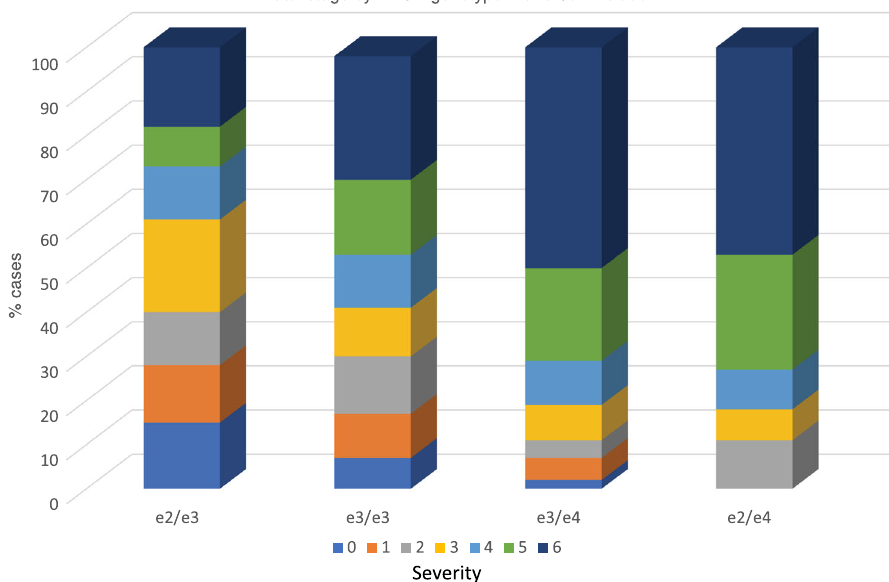
Fig. 3 Association of APOE e2/e4 genotype with Braak stage. Within each APOE genotype column, colored rows represent the relative proportion of cases in each severity stage. These proportions are expressed as percentages and add to 100. Note the similarity of e2/e4 cases to e3/e4 cases with respect to high levels of tau pathology. Braak stage 0 = no pathology; stage 6 = severe neocortical pathology.